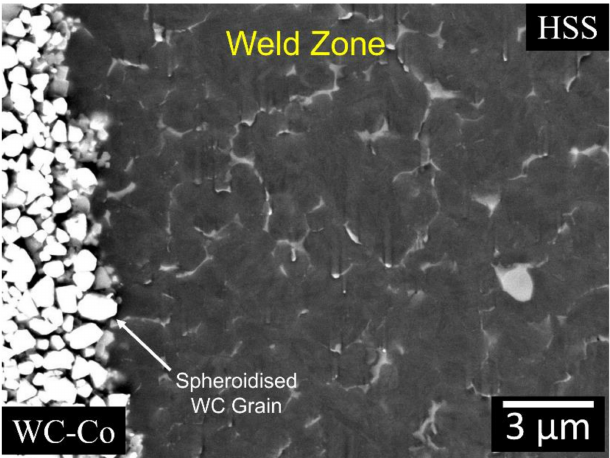
Figure 13. Higher FESEM magnification of the carbide dissolution region (Figure 10), details of the equiaxed grains on the HSS side and spheroidisation of WC particles on the composite